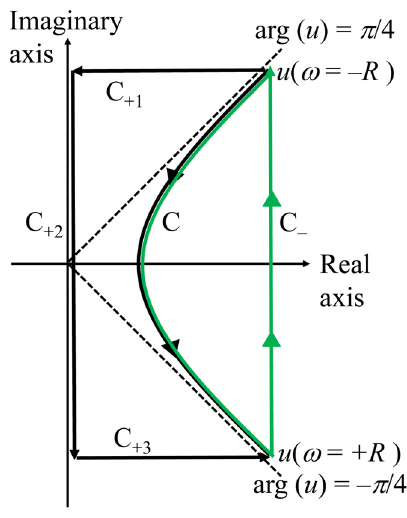
Figure 3. Integral paths in the complex ~ -plane used to evaluate the integral in Equation (18). When t <0, we can use the path colored converges to zero for this case. When t >0, green; integration along C – we adopt the black integral contour. Integration over C converges to zero, and C becomes Gauss’s integral in this case. +2